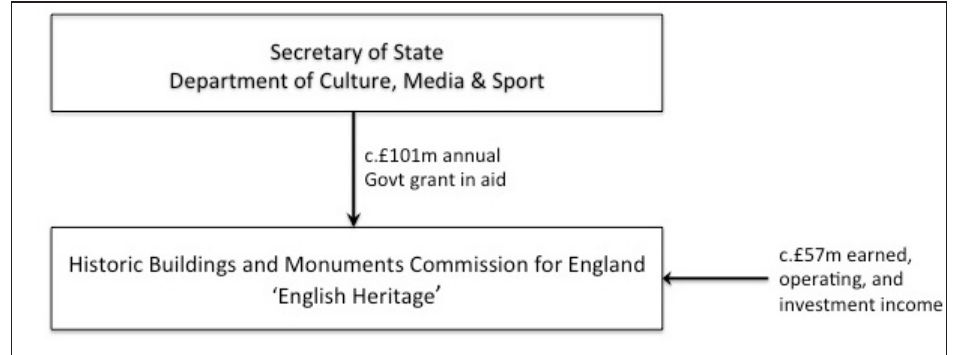
Figure 1: Illustration of the current funding model of English Heritage (figures supplied are from English Heritage’s most recent annual report,